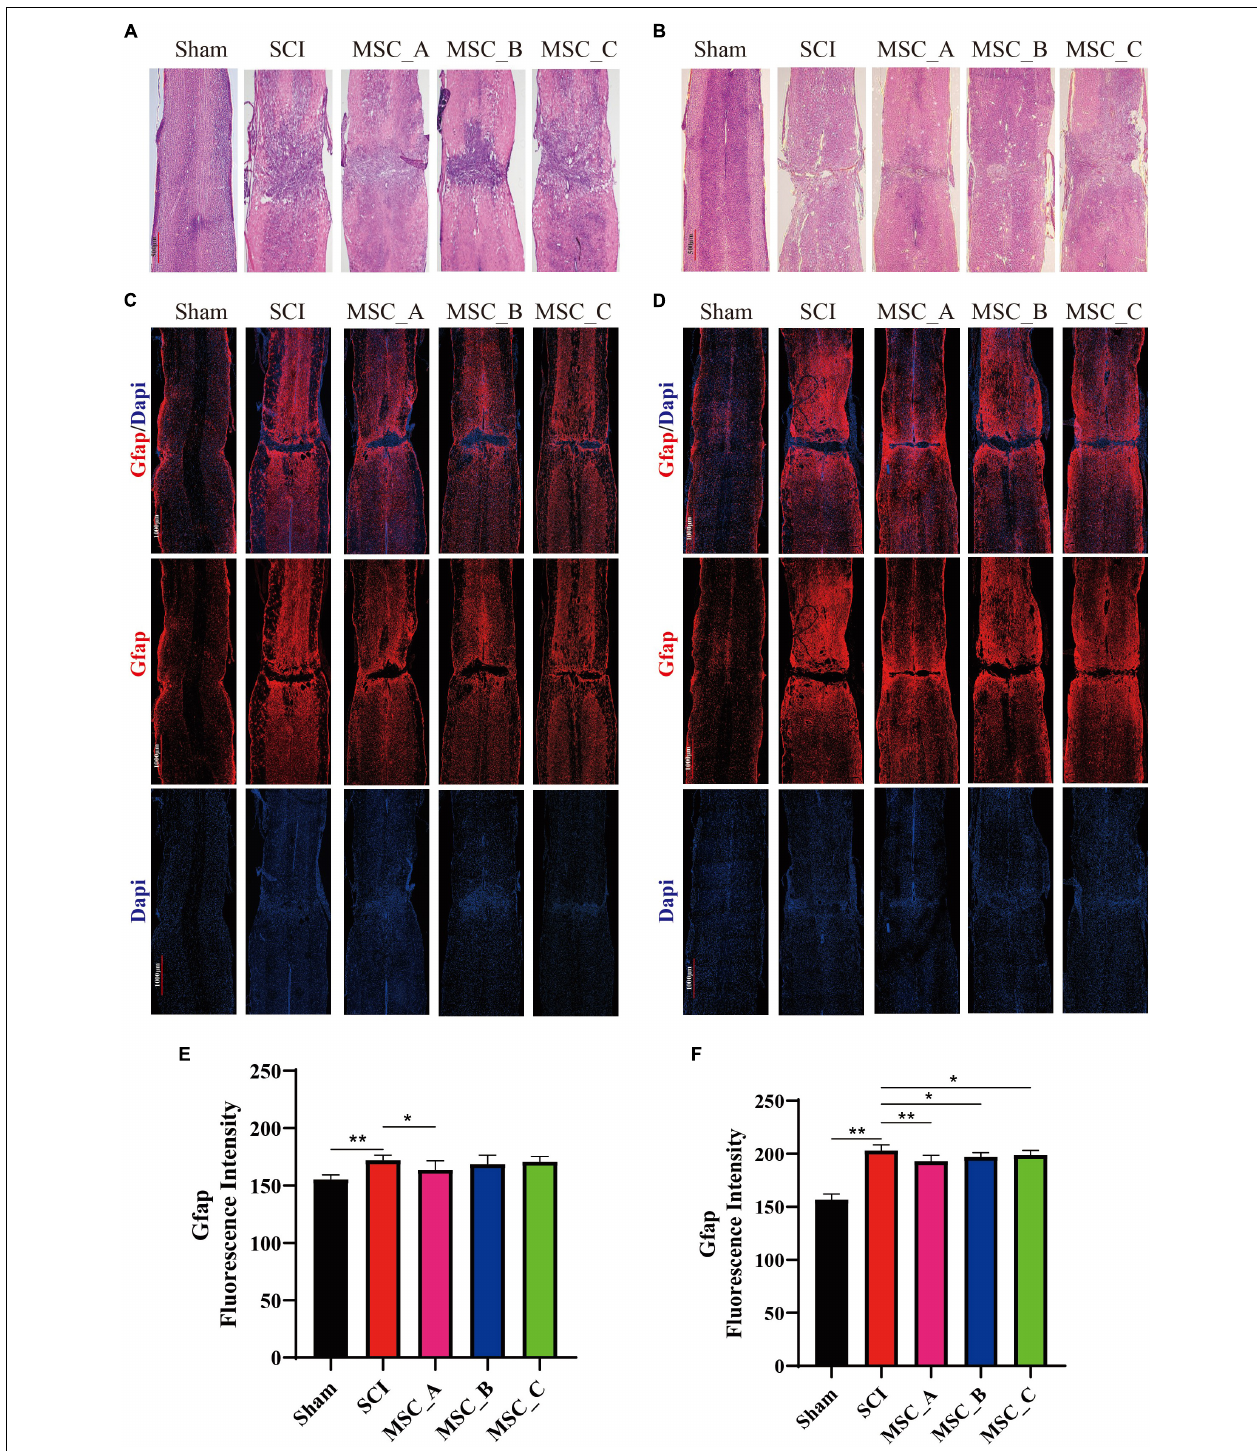
FIGURE 5 | Hematoxylin-eosin and Gfap immunofluorescence staining at 1 week and 1 month after hUCMSC treatment at dpo 3. Gross morphological examination of the spinal cord by H&E staining at 1 week (A) and 1 month (B) after hUCMSC transplantation. Confocal images of immunostaining confirmed the expression of glial fibrillary acidic protein (Gfap, in red) and nucleus [4 (cid:48) ,6-diamidino-2-phenylindole (DAPI), in blue] at 1 week (C) and 1 month (D) after hUCMSC transplantation. Quantification of the Gfap fluorescence intensity at 1 week (E) and 1 month (F) after hUCMSC transplantation. All data are presented as the mean ± SEM; n = 3; * p < 0.05; ** p <